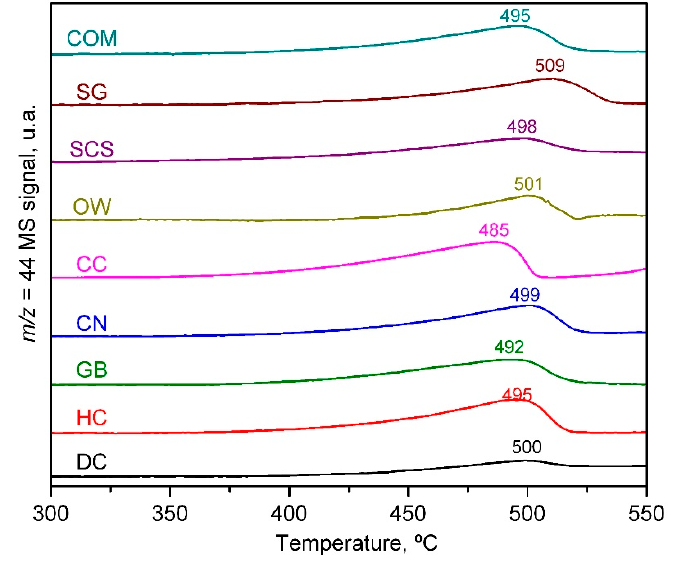
Figure 6. CH 4 -TPRe profiles of the bulk Co 3 O 4 catalysts in the low-temperature range (300–500 °C).